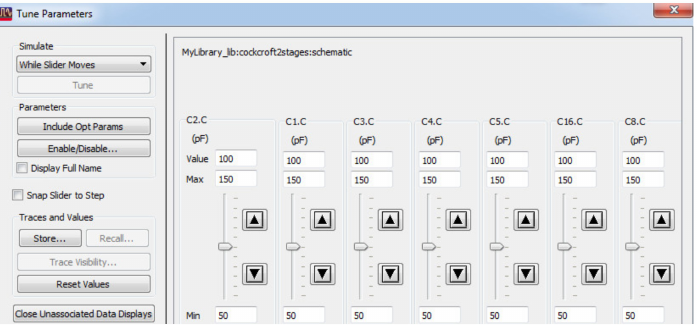
Figure 4. Tuning tool for finding values of capacitors in the voltage multiplier rectifier